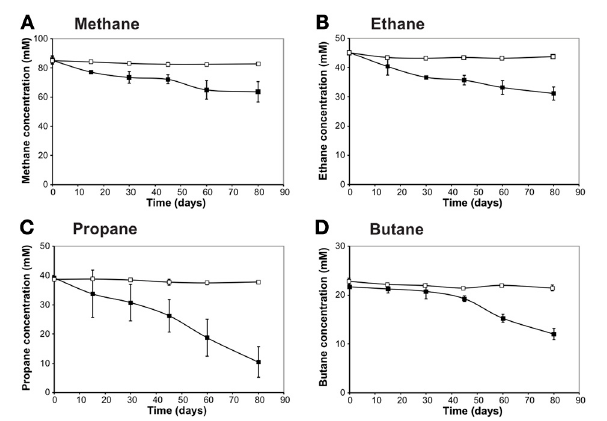
FIGURE 1 | Alkane consumption as a function of time by the Gulf of Mexico (GoM) site GB425 (dive 4645 and core 22) incubations. The alkane concentration in the headspace of the sediment incubations was measured using a Hewlett Packard 5890 Series II gas chromatograph equipped with a flame ionization detector, on a Restek Rt-XL Sulfur packed column. (A) methane; (B) ethane; (C) propane; and (D) butane. Rates of alkane consumption were calculated using all available time points based on a linear